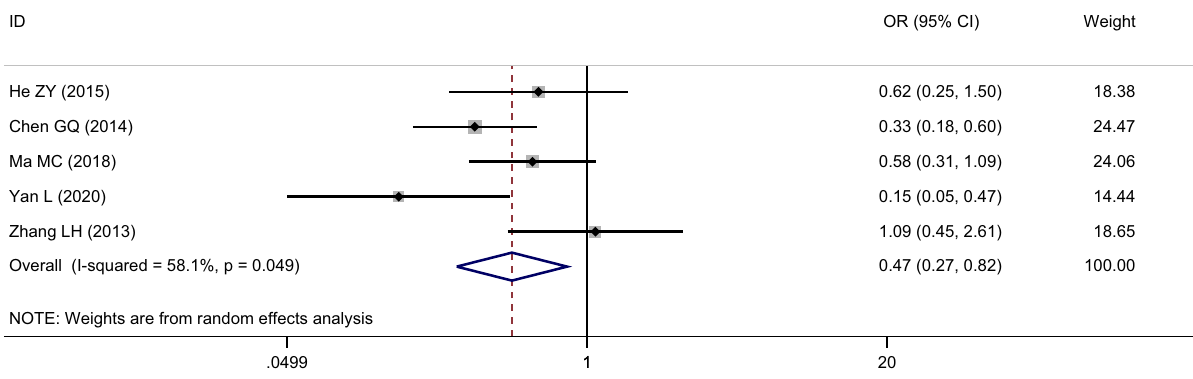
Overall (I-squared = 58.1%, p = 0.049) NOTE: Weights are from random effects analysis